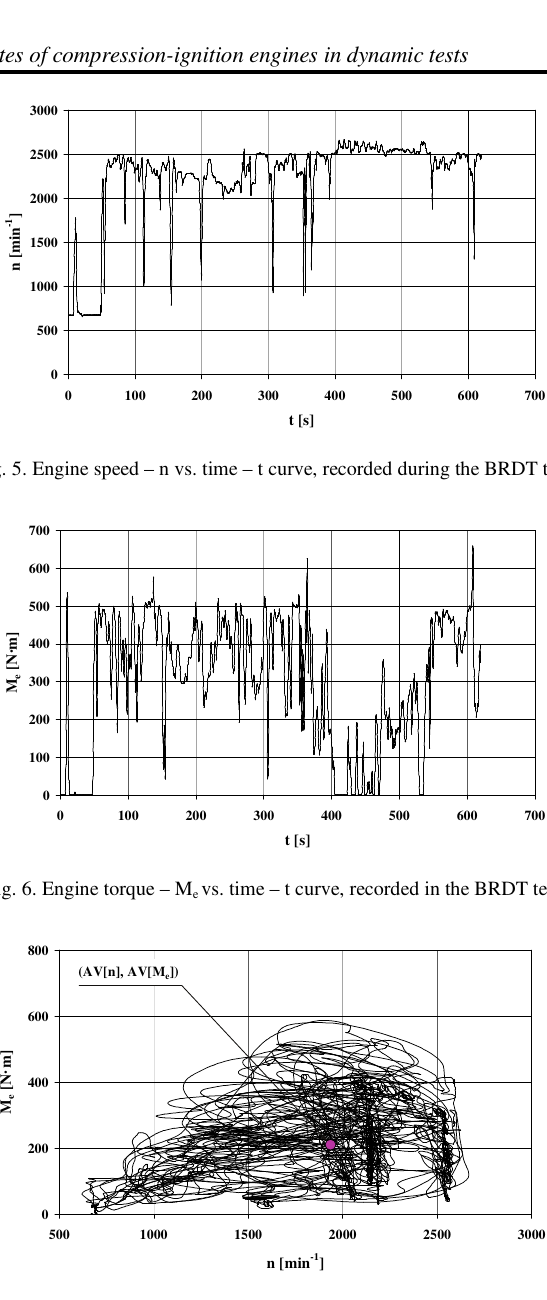
Fig. 3. Engine speed – n vs. time – t curve, recorded in the BBDT test